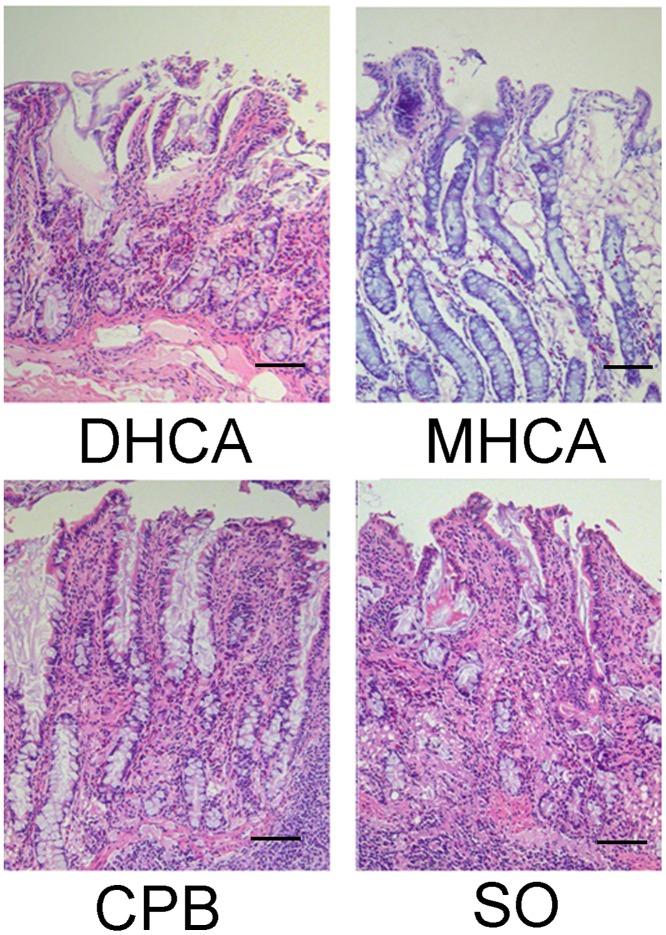
Hematoxylin-eosin staining of the intestinal tissue.The mucosal villi and glands were normal in the intestinal epithelia of the SO and CPB groups. Marked edema of the mucosal villi, increased gaps between the epithelial cells and inflammatory cell infiltration were observed in the MHCA and DHCA groups. Magnification: 100 folds; the scale bars indicate 100 μm.